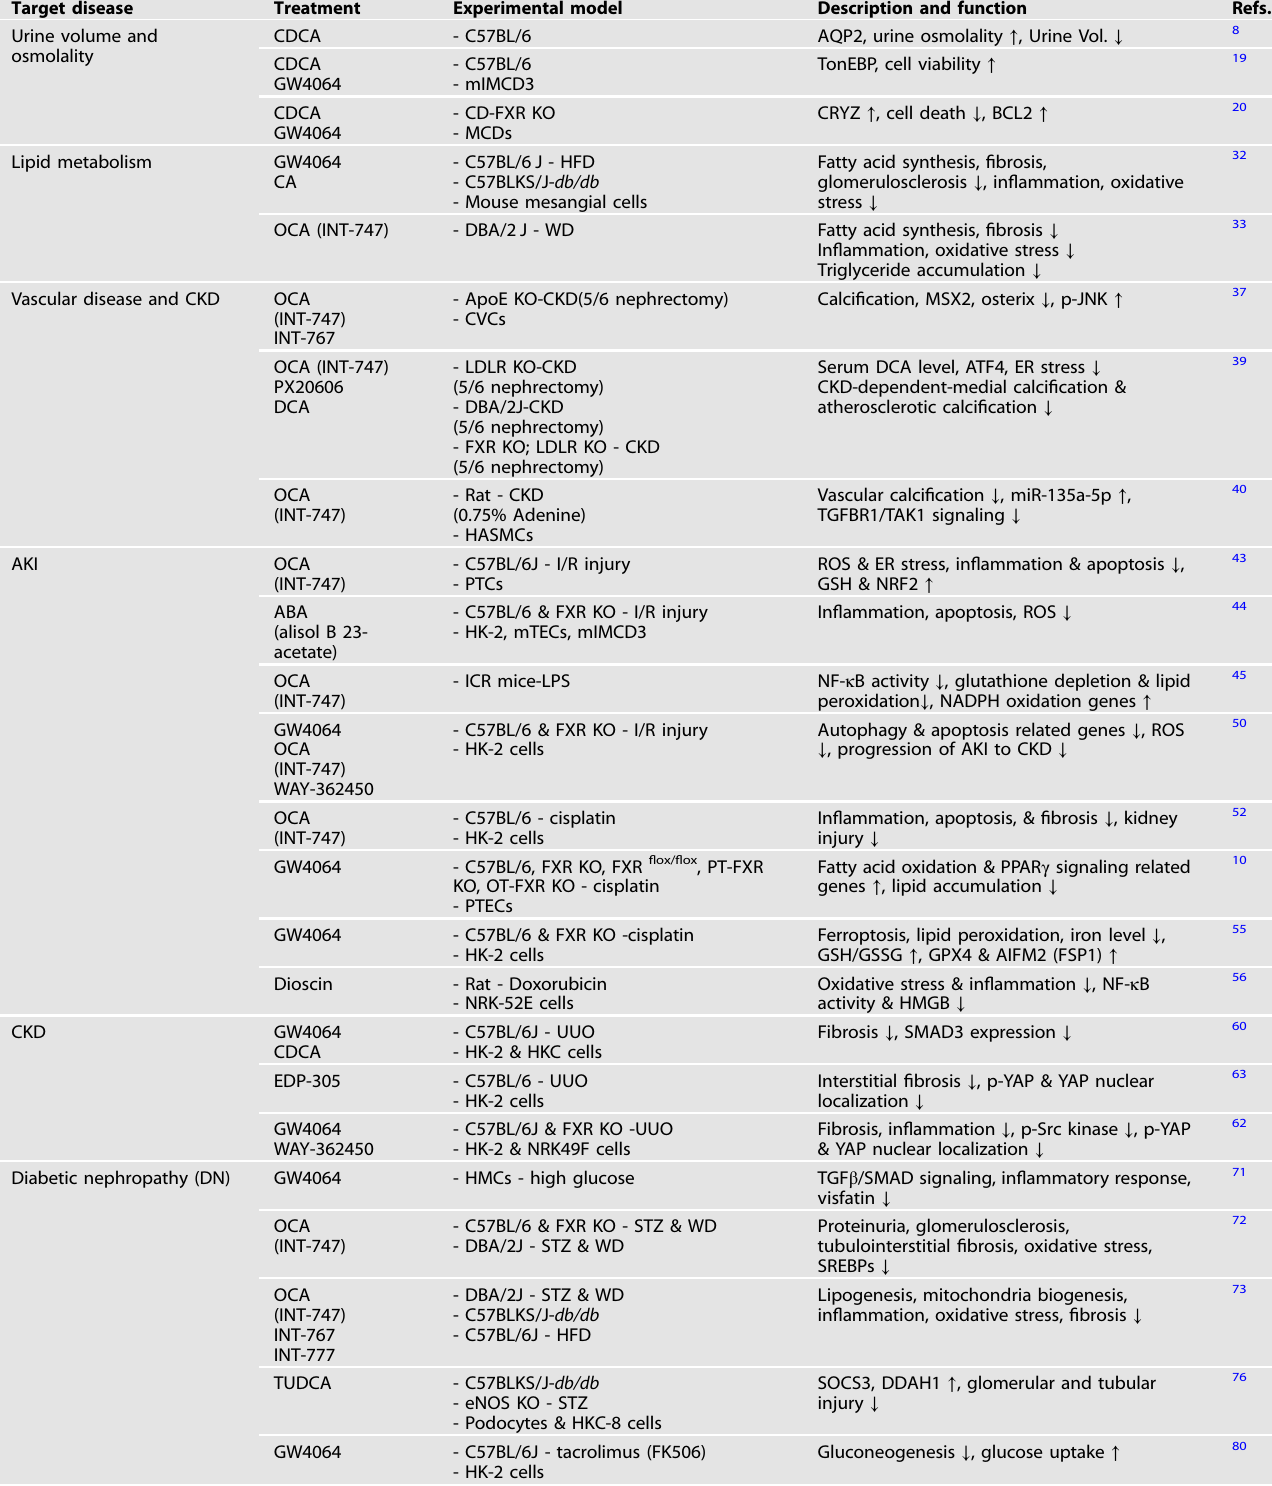
Table 1. Summary of the role of FXR in the physiology and pathophysiology of the kidneys. Target